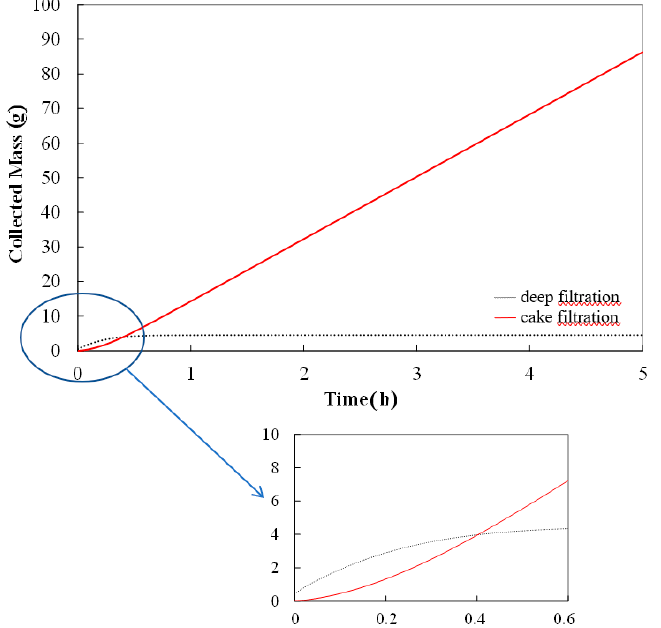
Figure 6. Variation of collected with time during filtration stages.